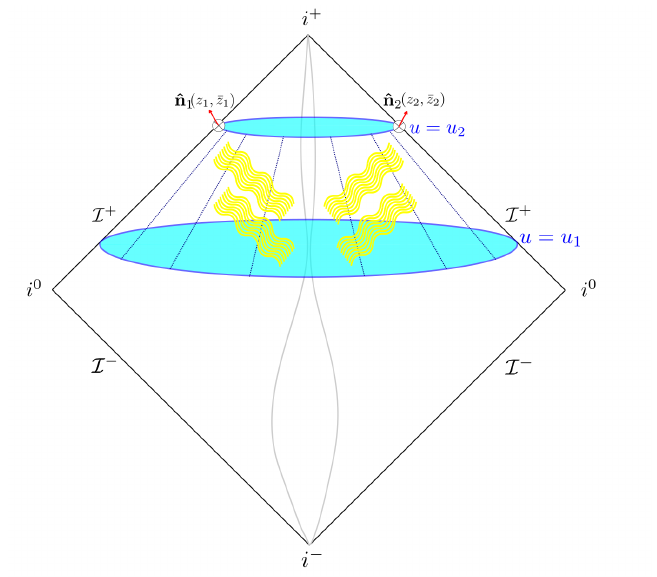
Figure 1. The radiation due to the scattering of two massive objects is captured by two detectors located at spatial infinity in the directions ˆ n